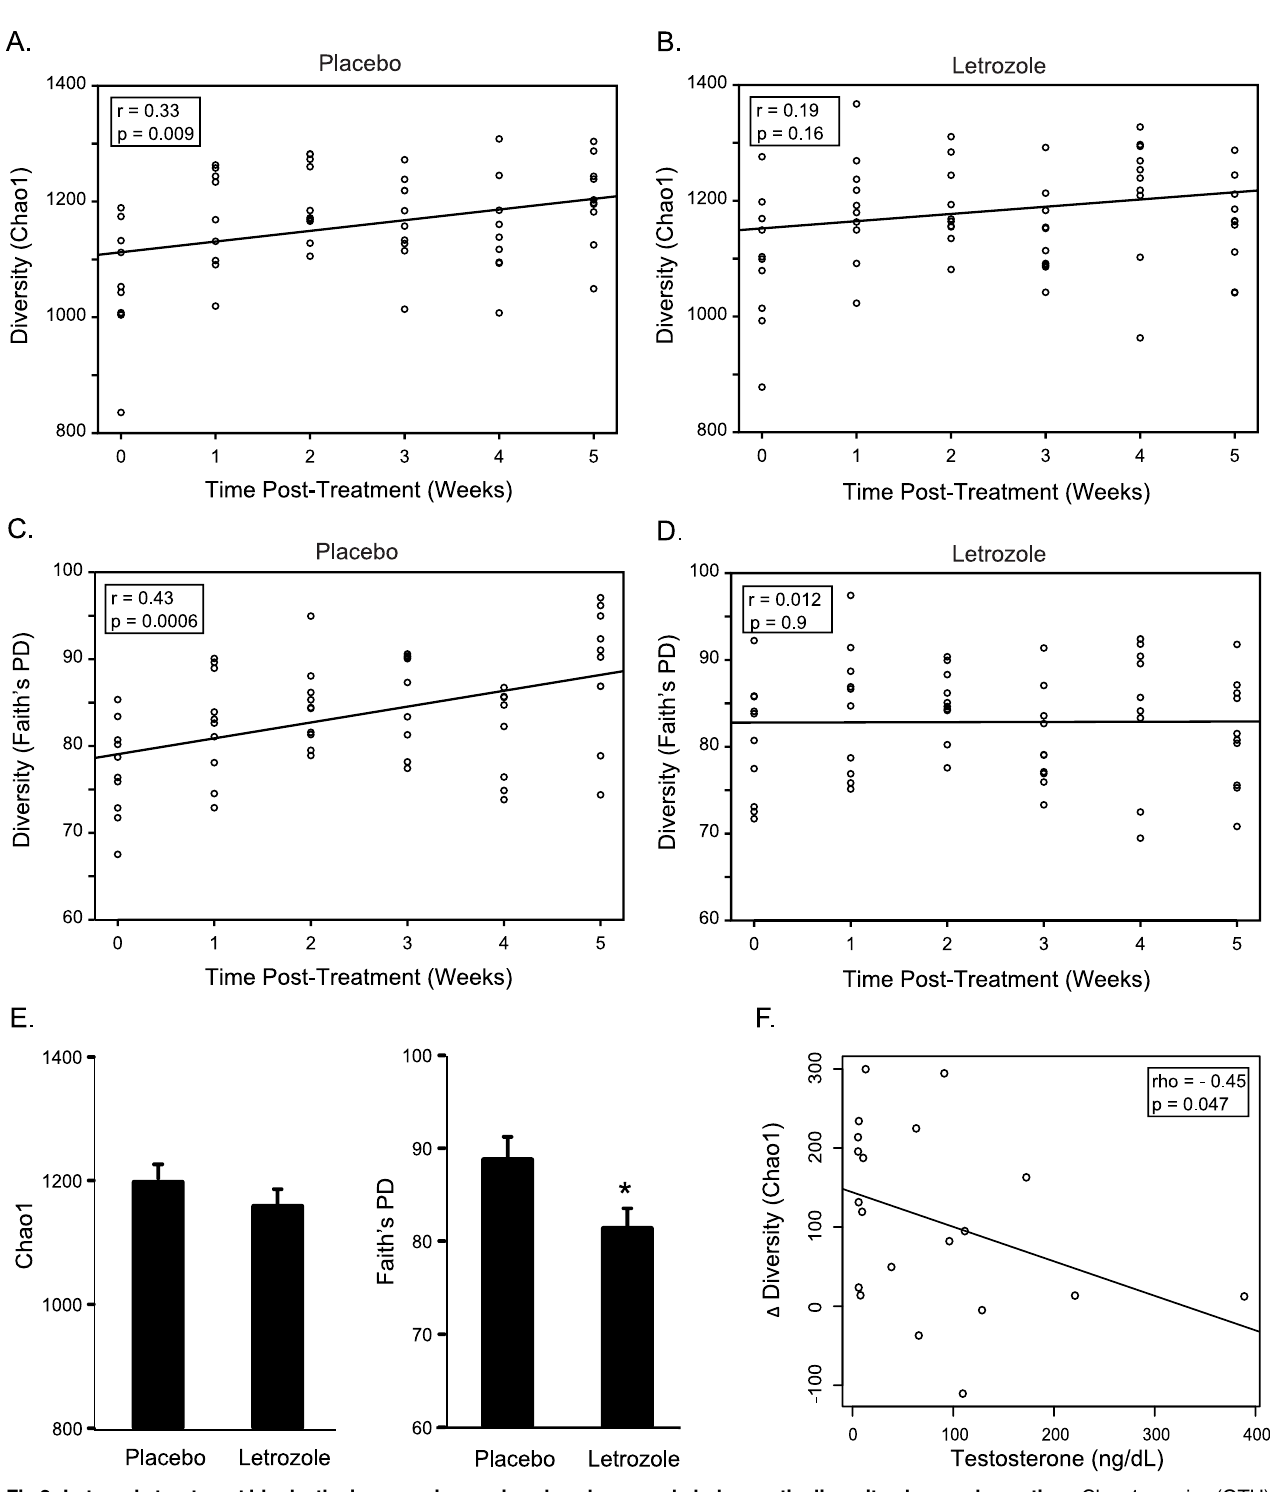
PLOS ONE | DOI:10.1371/journal.pone.0146509 January 5, 2016 6 /